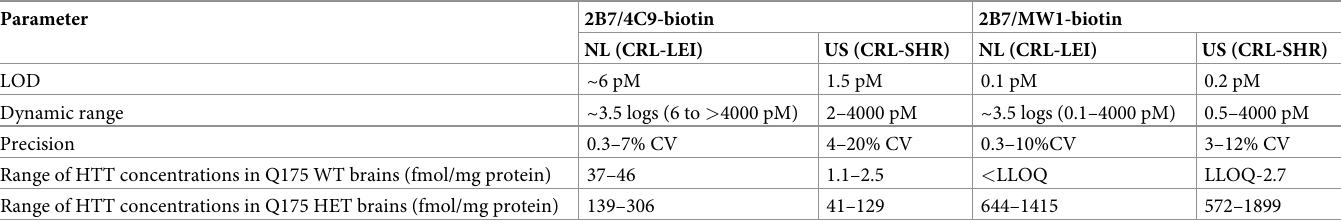
Table 2. Comparison of HTT MSD assay performance in two independent laboratories. Performance measures derived from the dataset shown in Fig 5.